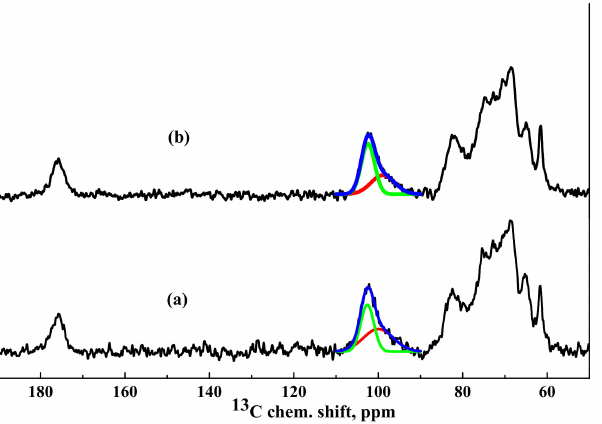
Figure 8. 13 C NMR spectra of cross-linked ( a ) HEC/SA CaCl2 and ( b ) HEC/SA-5 CaCl2